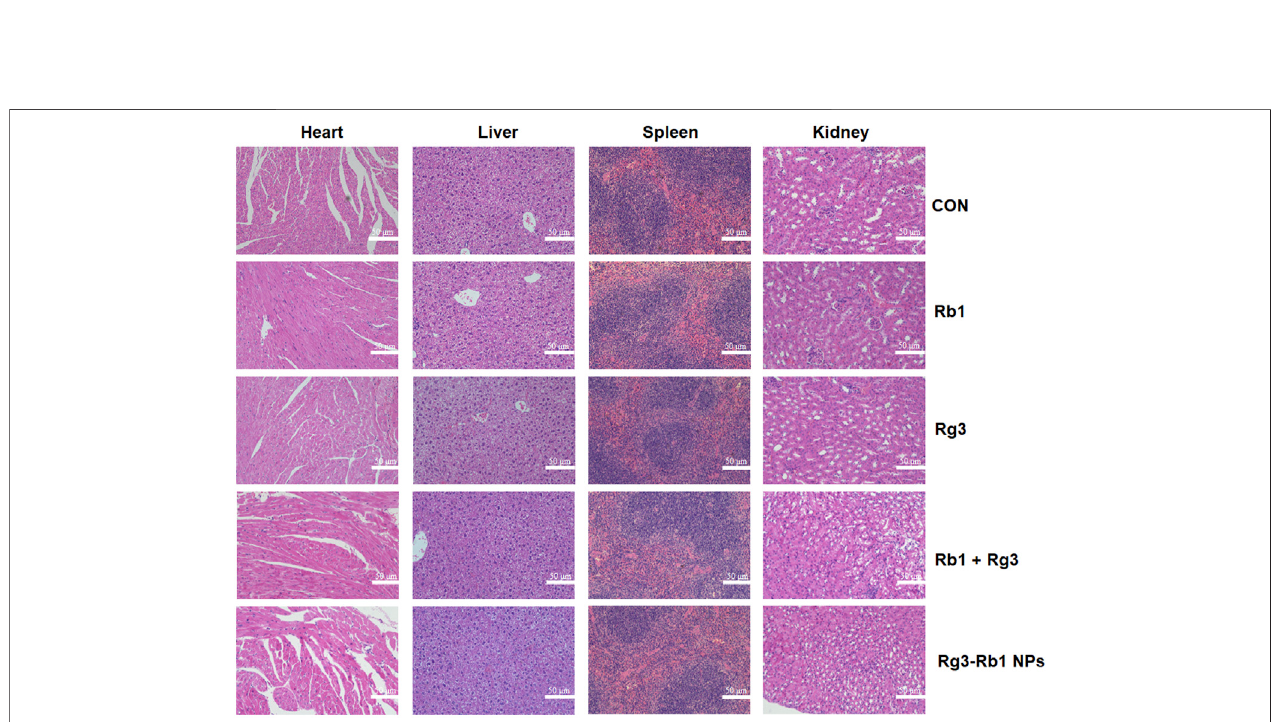
FIGURE 6 | Hematoxylin and eosin-stained image of 4T1 orthotopic mammary mouse. Scale bar = 50 μ m.